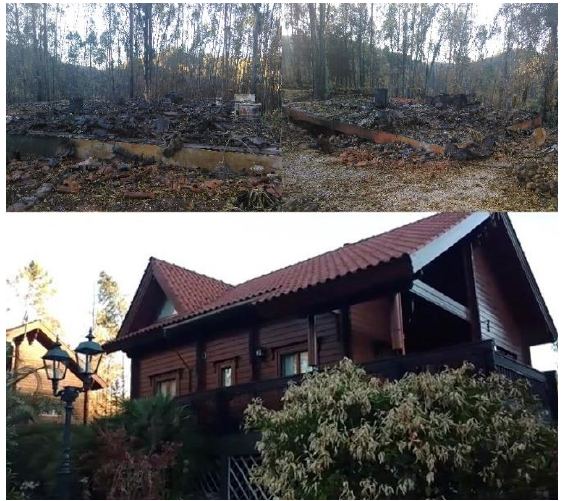
Figure 5. Example of totally destroyed wooden houses. The picture bellow refers to one of the destroyed houses before the fire, and it was taken from Google Earth Street View.